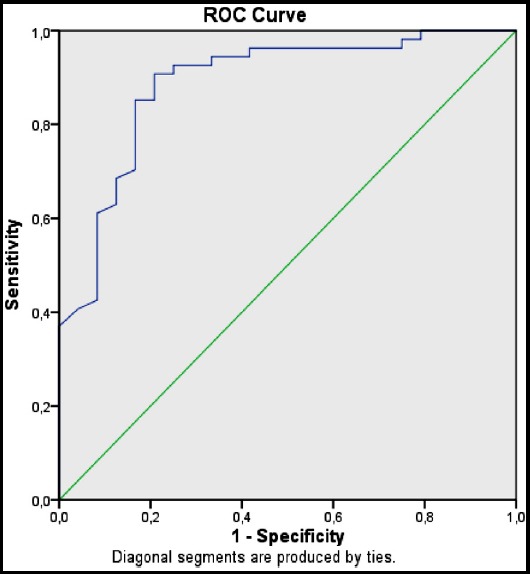
ROC curve comparing endocan levels with PSI class